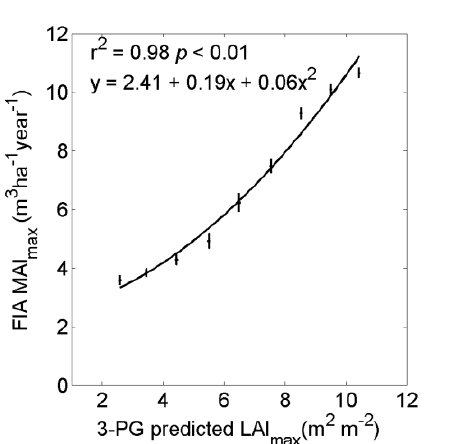
Figure 1. Simulated maximum leaf area index (LAI closely related to the maximum mean annual increment (MAI and age measurements acquired from 2000 to 2006 on >3356 FIA (Forest Inventory and Analysis) survey plots in Oregon and Washington